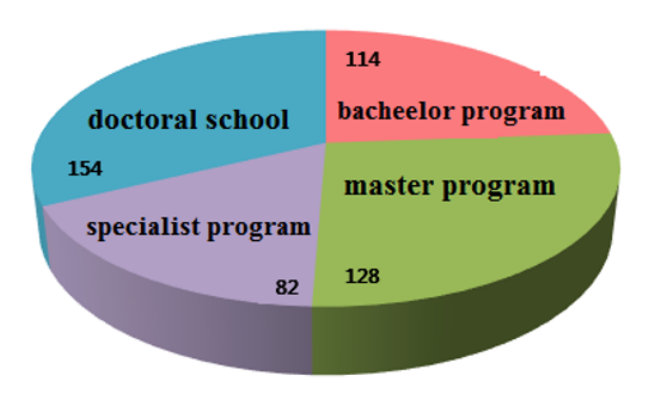
Fig. 1. The number of MEPs by training levels.